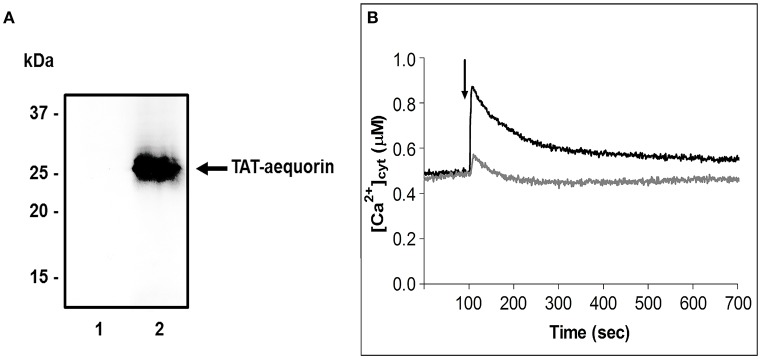
Spm affects cytosolic Ca2+ concentration in germinating pear pollen. (A) Immunoblot analysis assessing the delivery of TAT-fused aequorin into germinating pollen. Samples were incubated in the absence (1) or presence (2) of TAT-aequorin (30 μM) for 10 min. Total protein extracts (30 μg) were separated by 12.5% SDS-PAGE, transferred onto PVDF and incubated with an anti-polyHis antibody. (B) Monitoring of cytosolic Ca2+ dynamics in germinating pollen by using TAT-aequorin. Cytosolic free Ca2+ concentration ([Ca2+]cyt) was measured after 10 min incubation of germinating pollen with TAT-aequorin and subsequent challenge (arrow, 100 s) with either the germination medium (gray trace) or 100 μM Spm (black trace). Ca2+ traces are representative of three independent experiments that gave very similar results.